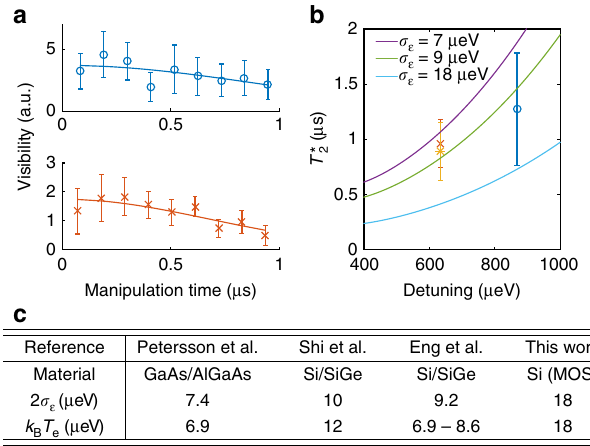
fi t with a Fig. 4 Coherence time. a Visibility of ST rotations vs. time and T (cid:4) 2 Gaussian decay model for ϵ = 868 μ eV (top) and 635 μ eV (bottom). The results are plotted in b . Error bars represent the 95% con fi dence interval. at both detunings is consistent with residual exchange and a b The T (cid:4) 2 detuning noise of σ ϵ = 9 μ eV. Error bars represent the 95% con fi dence interval. c Table comparing charge noise in a variety of material systems. All show a similar noise level that seems related to the electronic temperature T e . k B is the Boltzmann constant. References: Petersson Fig. 3 Detuning dependence of exchange. a , b Experimental a and model b et al. 47 , Shi et al. 48 , Eng et al. triplet probability vs. detuning and manipulation time. The oscillations on the time axis are the hyper fi ne-driven rotations. The phase and shape of the oscillations are well reproduced; however, the mechanisms limiting the its Supplementary Information fi les. Additional data (e.g. source visibility are detailed in the Supplementary Note 8. c Left axis: Frequency f data for fi gures) are available from the corresponding author of the oscillations vs. detuning, extracted from fi ts to a . This corresponds to upon reasonable request. the S – T 0 energy gap, allowing a fi t for model parameters t S = 19 μ eV, t T = 31 μ eV and A /2 h = 50 MHz. Error bars represent the 95% con fi dence ffiffiffiffiffiffiffiffiffiffiffiffiffiffiffiffiffiffiffiffiffiffiffiffiffiffi interval. Right axis: Exchange J calculated from the frequency after removing the hyper fi ne contribution J = h ¼